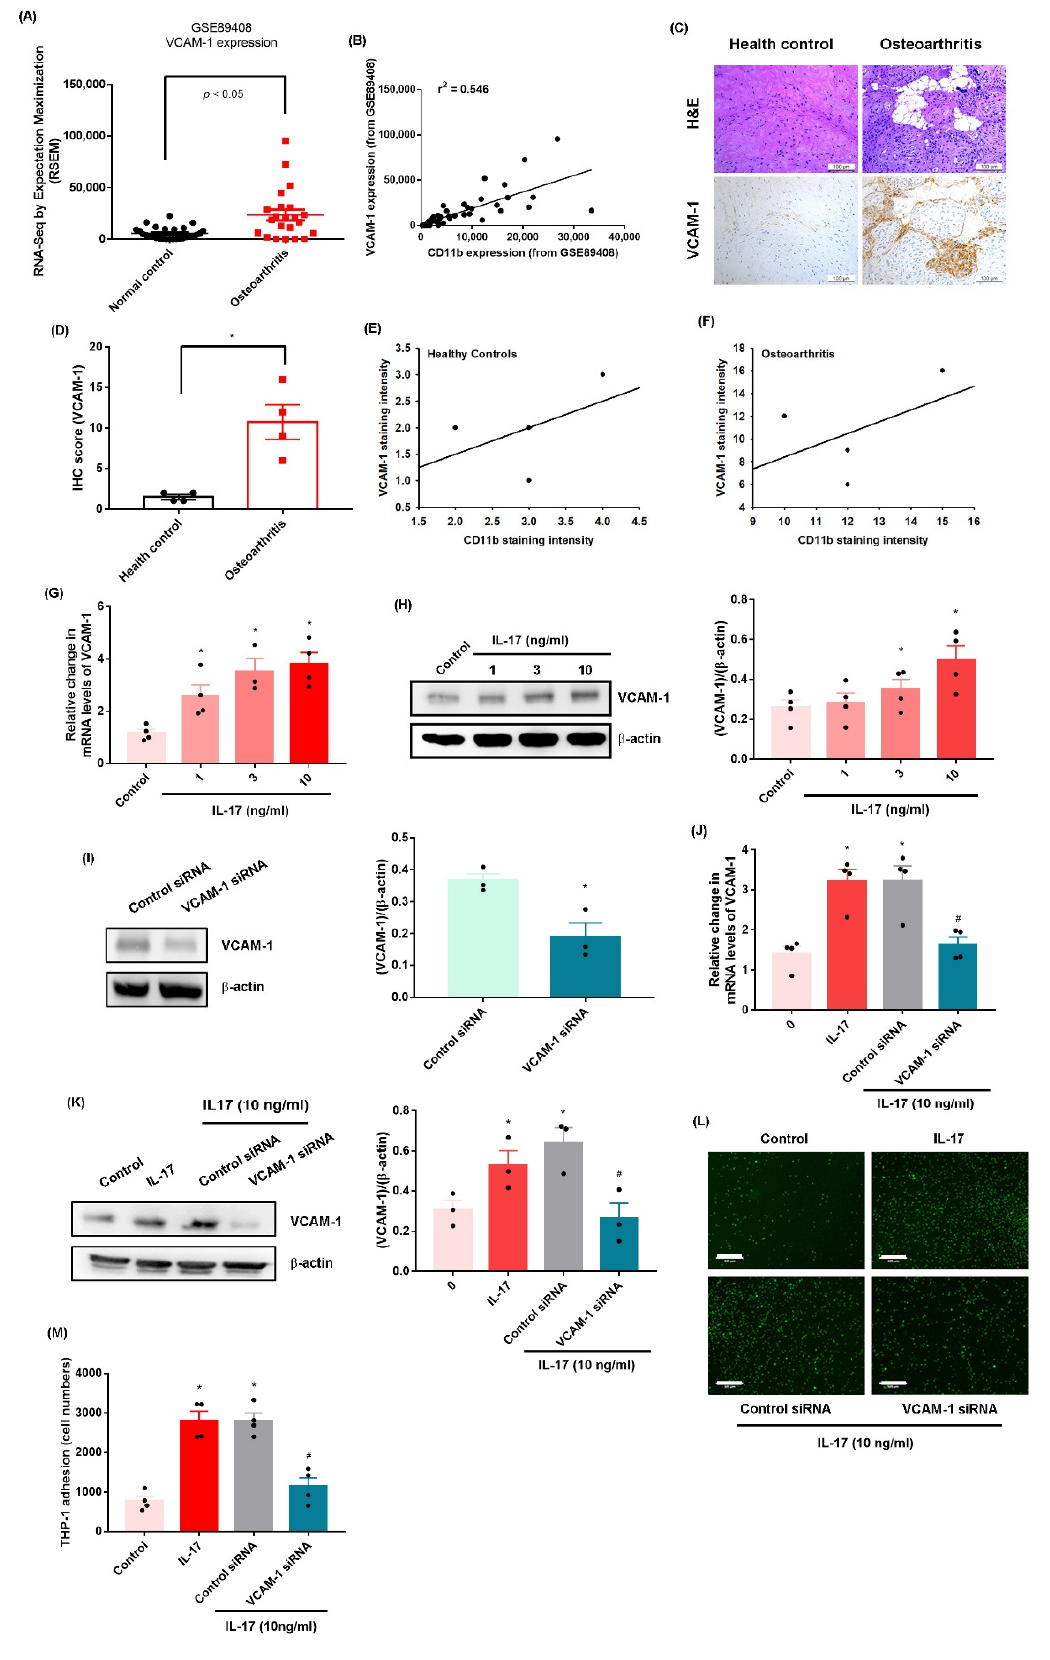
Figure 2. IL-17 promotes monocyte adhesion in OASFs through upregulating VCAM-1 produc- tion. ( A ) Levels of VCAM-1 were investigated in synovial tissue collected from the GEO database containing OA patients and healthy controls. ( B ) Spearman’s rank correlation coefficient testing identified significant, positive correlations between VCAM-1 and CD11b. ( C – F ) IHC staining for